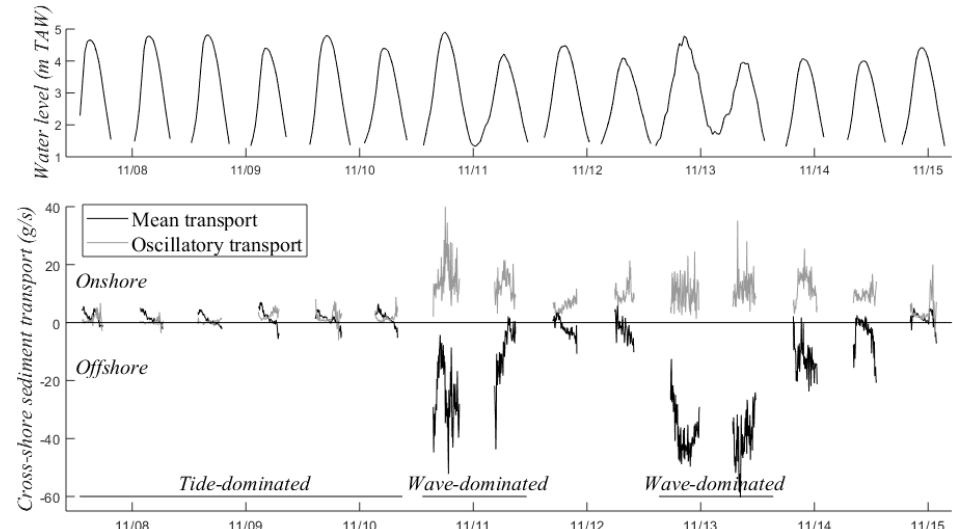
Figure 6. Mean and oscillatory cross-shore suspended sediment transport at 10 cm above the bed over the first week of the November campaign (bottom) with the water level for reference (top).